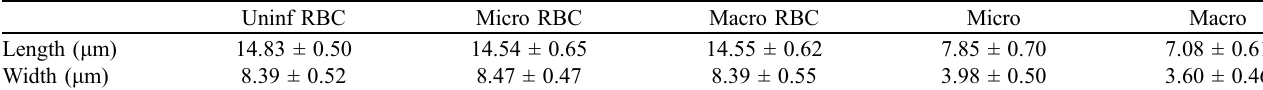
Table 1. Size of parasites and red blood